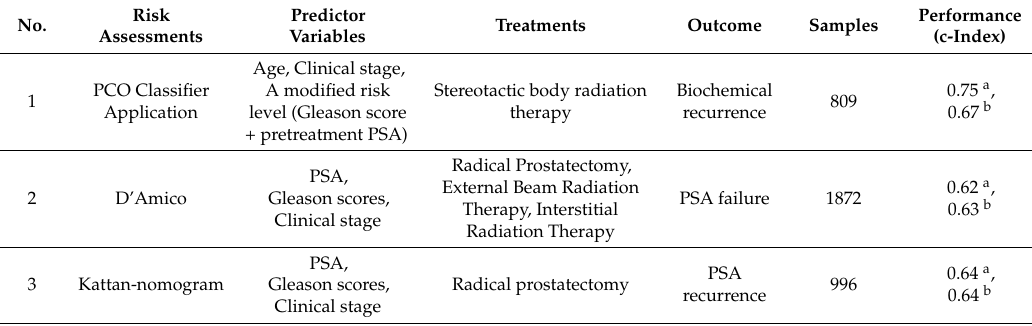
Figure 3. BCR (Kaplan–Meier Curve). N = 809, Confidence interval = 95%. Table 4. Risk assessments